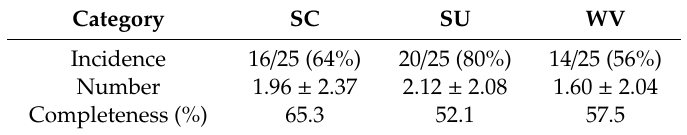
Table 4. Incidence, number, and completeness of the accessory canal